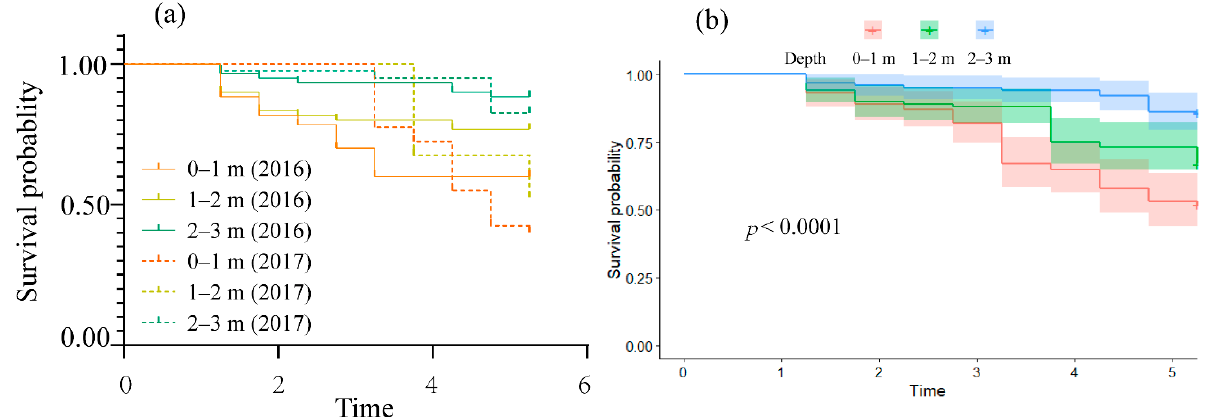
Figure 3. Survival probability of S. prenanti confined in 0–1 m, 1–2 m, 2–3 m water depths as a function of exposure duration during the dam spill season in 2016 and 2017; ( a ) survival curve for six scenarios; ( b ) survival probability with 95% confidence interval using Cox proportional hazard model for S. prenanti at various water depths.